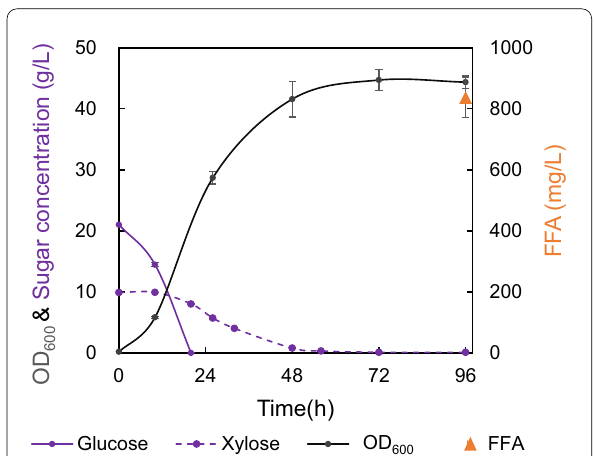
Fig. 2 Co-feed of glucose and xylose for fatty acid over-production. Fermentation was carried out in minimal medium containing a mixture of 20 g/L glucose and 10 g/L xylose (20G 220 rpm for 96 h. Samples were taken to analyze the cell growth, FFA titer and sugar concentration. Data are presented as mean (n